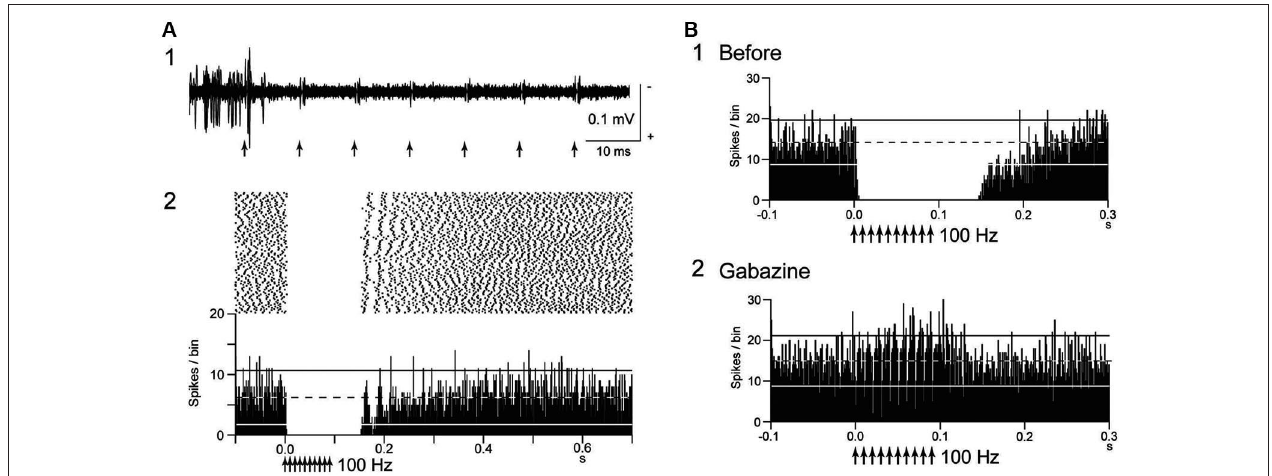
the timing of local stimulation. Spontaneous discharges of the GPi neuron were completely inhibited by the stimulation. (B) Effect of local injection of gabazine (GABA A receptor antagonist) in the vicinity of the recorded GPi neuron on inhibition of spontaneous activity induced by GPi-HFS. The inhibition was abolished after gabazine injection. Modified from Chiken and Nambu